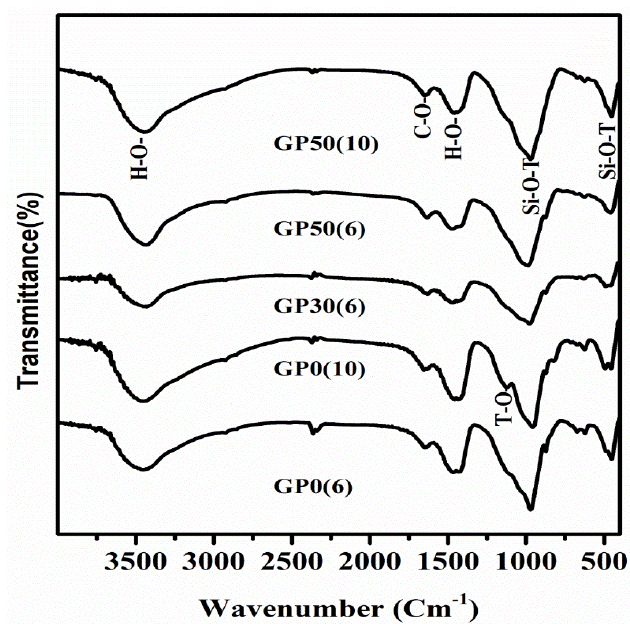
Figure 5. FTIR spectra for the Geopolymer cement without VA and Geopolymer cement based MSWI-FA-VA system. Table 3. IR Characteristic bands of Geopolymer MSWI-FA and MSWI-FA-VA.